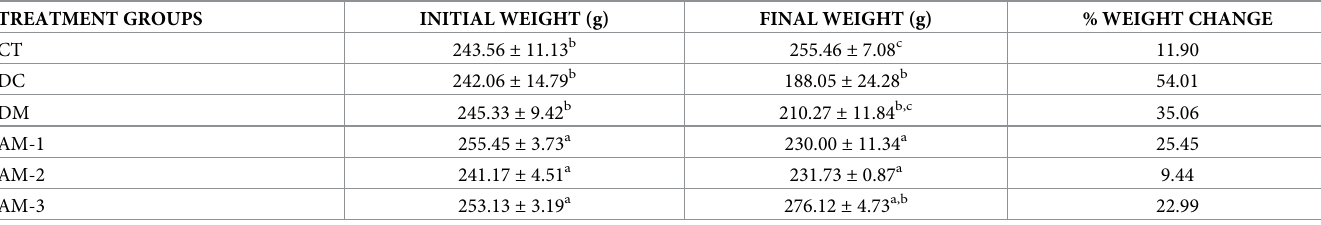
Table 3. Body weight of alloxan-induced diabetic rats before and after oral administration of aqueous extract of A . muricata peels. TREATMENT GROUPS